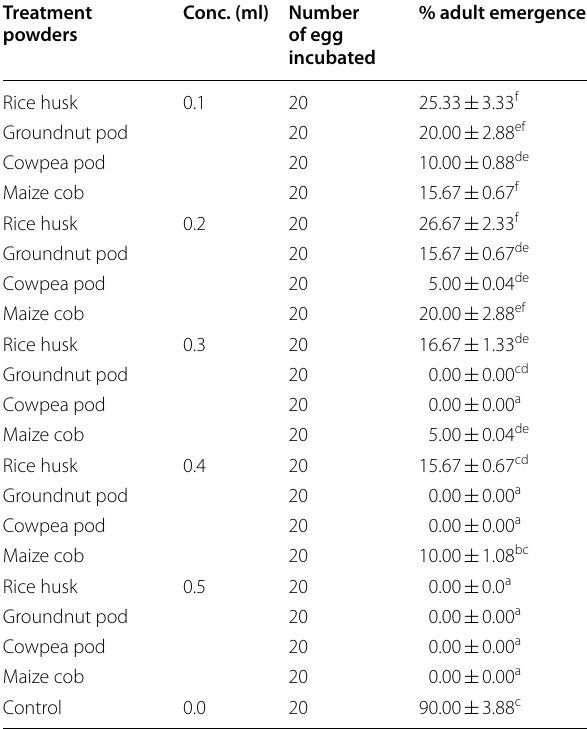
Table 6 Survival of S. cerealella eggs treated with agro waste powders Treatment Conc. (ml) Number powders of